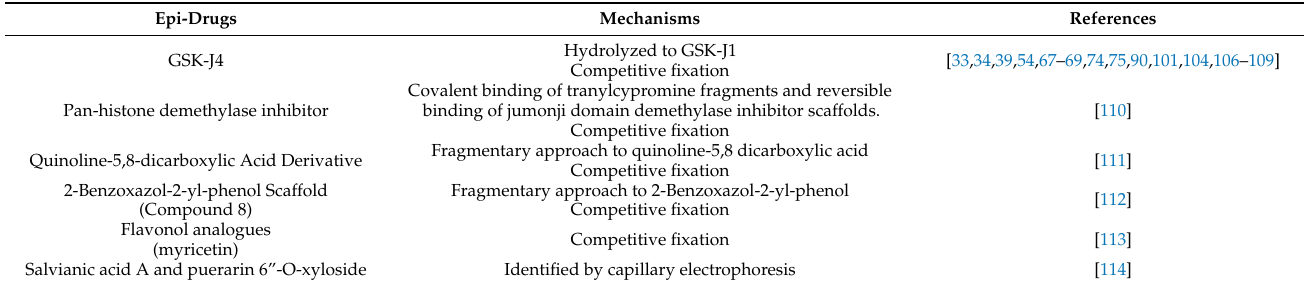
Table 2. Mechanisms of jumonji Domain-Containing Protein 3 demethylase (JMJD3)